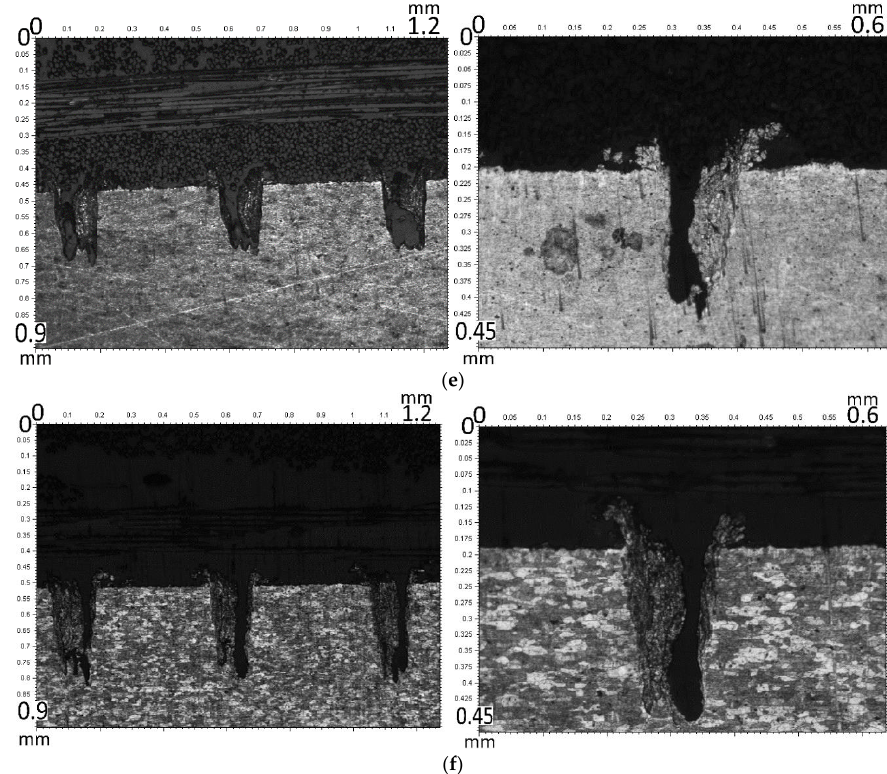
Figure 10. Joining results with different AR grooves: ( a ) run A in Table 6; ( b ) run B in Table 6; ( c ) run C in Table 6; ( d ) run D in Table 6; ( e ) run E in Table 6; ( f ) run F in Table 6.